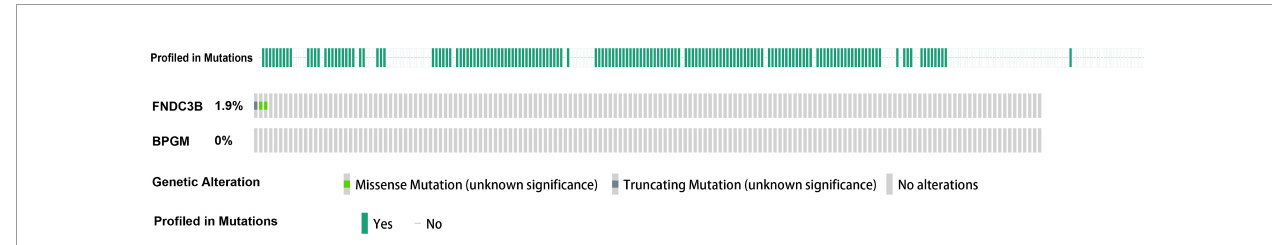
FIGURE 6 | Mutation analysis of FNDC3B and BPGM in CCa. There were 1.9% genomic alterations of FNDC3B in CCa, and there were 0% genomic alterations of BPGM in CCa.